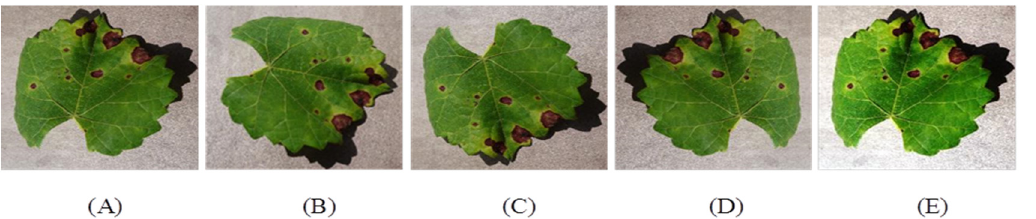
Figure 4. Data Pre-processing ( A ) Original image, ( B ) 90 ◦ rotated image, ( C ) Vertically flipped image, ( D ) Horizontally flipped image, ( E ) Intensified image.